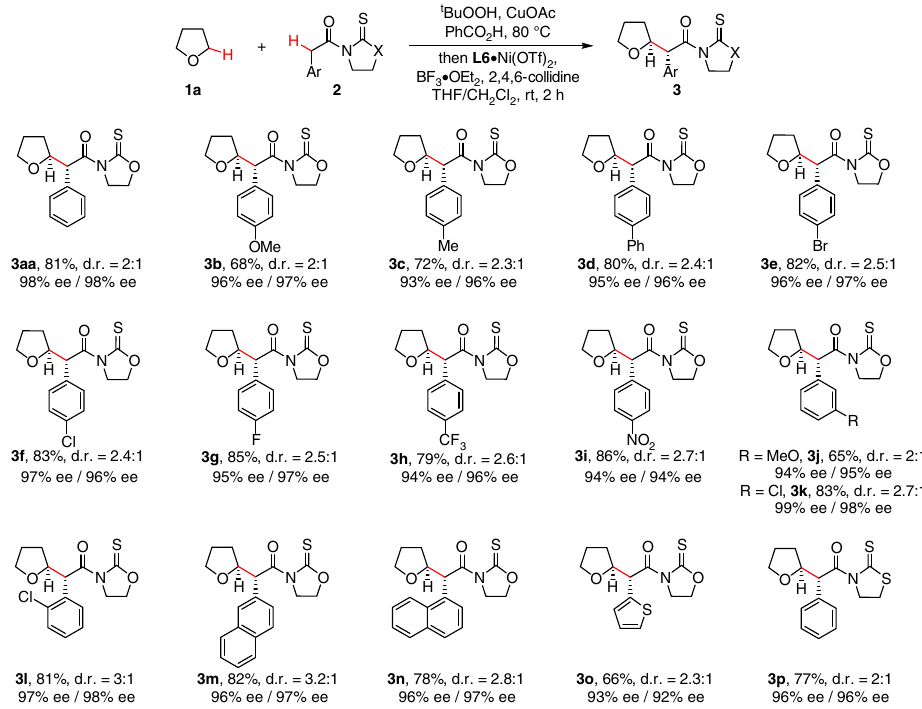
Fig. 1 The scope of α -aryl acetic acid derivatives. Conditions: PhCOOH (0.5 mmol, 2.5 equiv), CuOAc (2.5 mol%), t BuOOH in decane (2.5 equiv) in THF (1.0 mL) at 80 °C for 2 h, followed by 2 (1.0 equiv), L6·Ni(OTf) 2 (10 mol%), 2,4,6-collidine (3.0 equiv) and BF 3 ·OEt 2 (4.0 equiv) in THF/CH 2 Cl 2 (0.3 mL/ 0.1 mL) at rt for 2